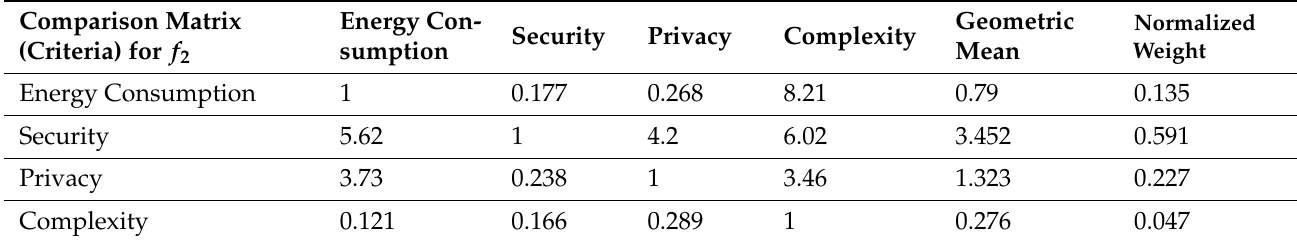
Table 6. Pairwise comparison matrix of criteria for function approximation.